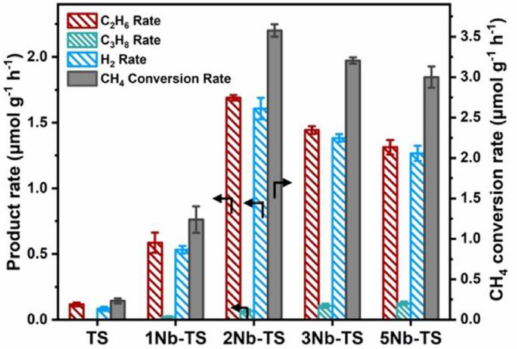
Figure 3. The hydrocarbon products, H 2 yields, and the CH 4 conversion rate over Nb-T [39]. Copy- right 2021, John Wiley and